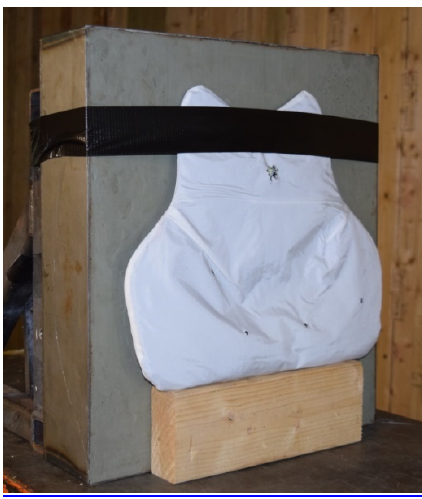
Figure 4. Roma Plastilina No. 1 used as a backing material for survivability assessment [17].